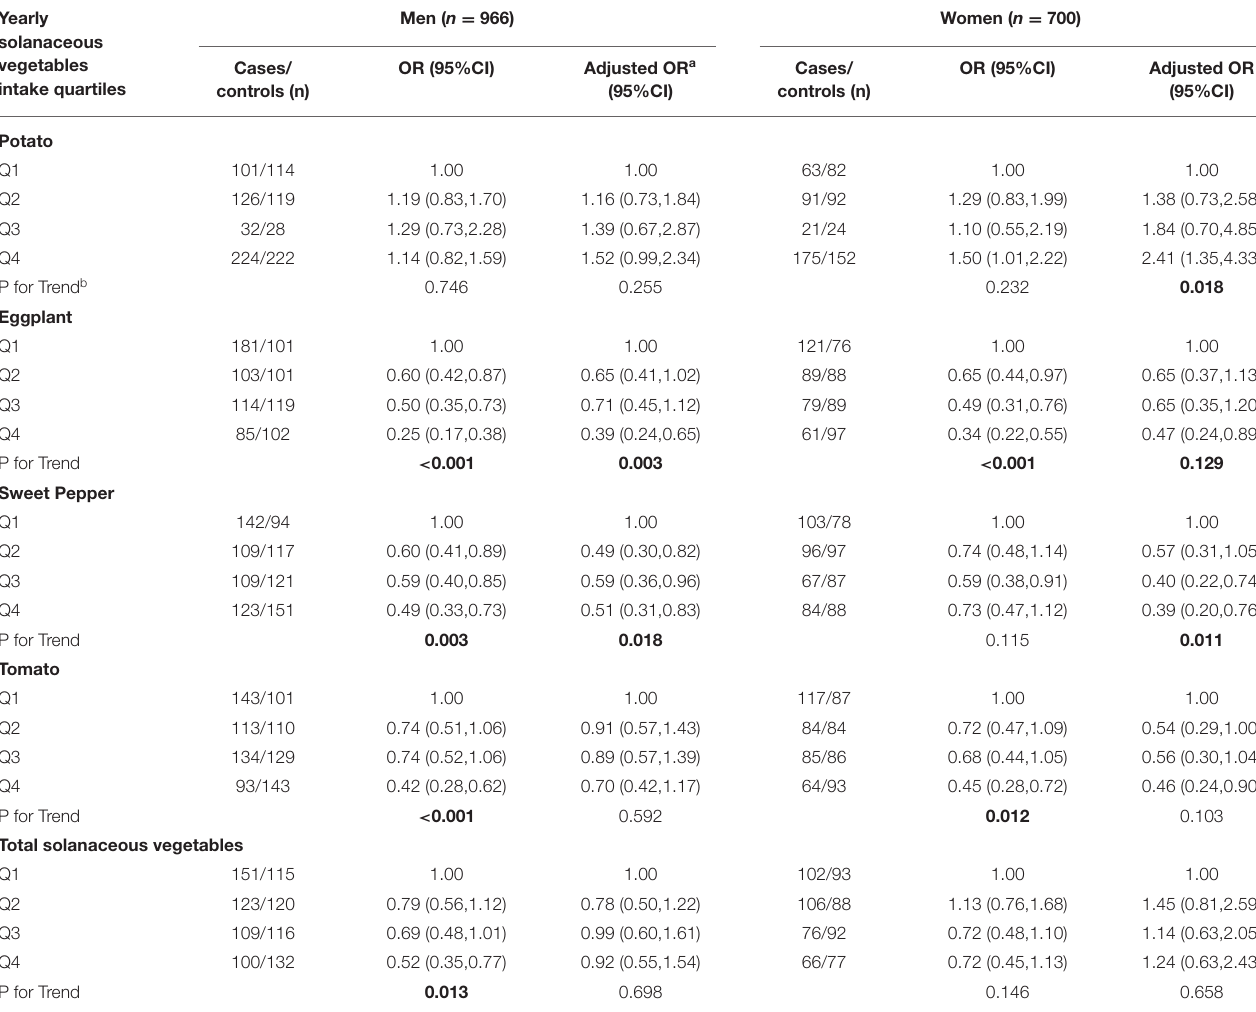
TABLE 5 | Odds ratios (ORs) and 95% confidence intervals (CIs) for the association of yearly solanaceous vegetables intake and colorectal cancer risk according to gender. Yearly solanaceous vegetables intake